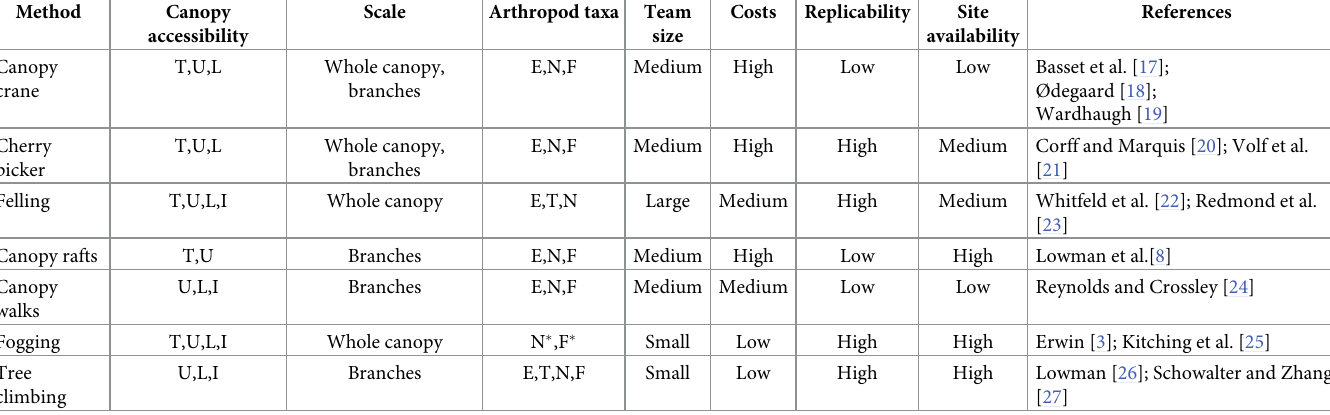
Table 1. Summary characteristics of forest canopy sampling methods that allow active sampling of arthropods by manual search, beating, sweeping, or fogging. The trapping methods are not listed. Characteristics include Canopy accessibility (accessibility of tree strata: T (terminal branches), U (upper canopy), L (lower canopy), I (inner canopy)); suitable Scale of sampling (whole canopy vs. individual branches), Arthropod taxa sampled (E (endophytic), T (trunk-nesting), N (non-flying exophytic herbivores and predators), F